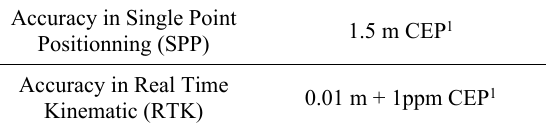
Table 1 : Technical characteristics of ZED-F9P, (Ublox, 2019)